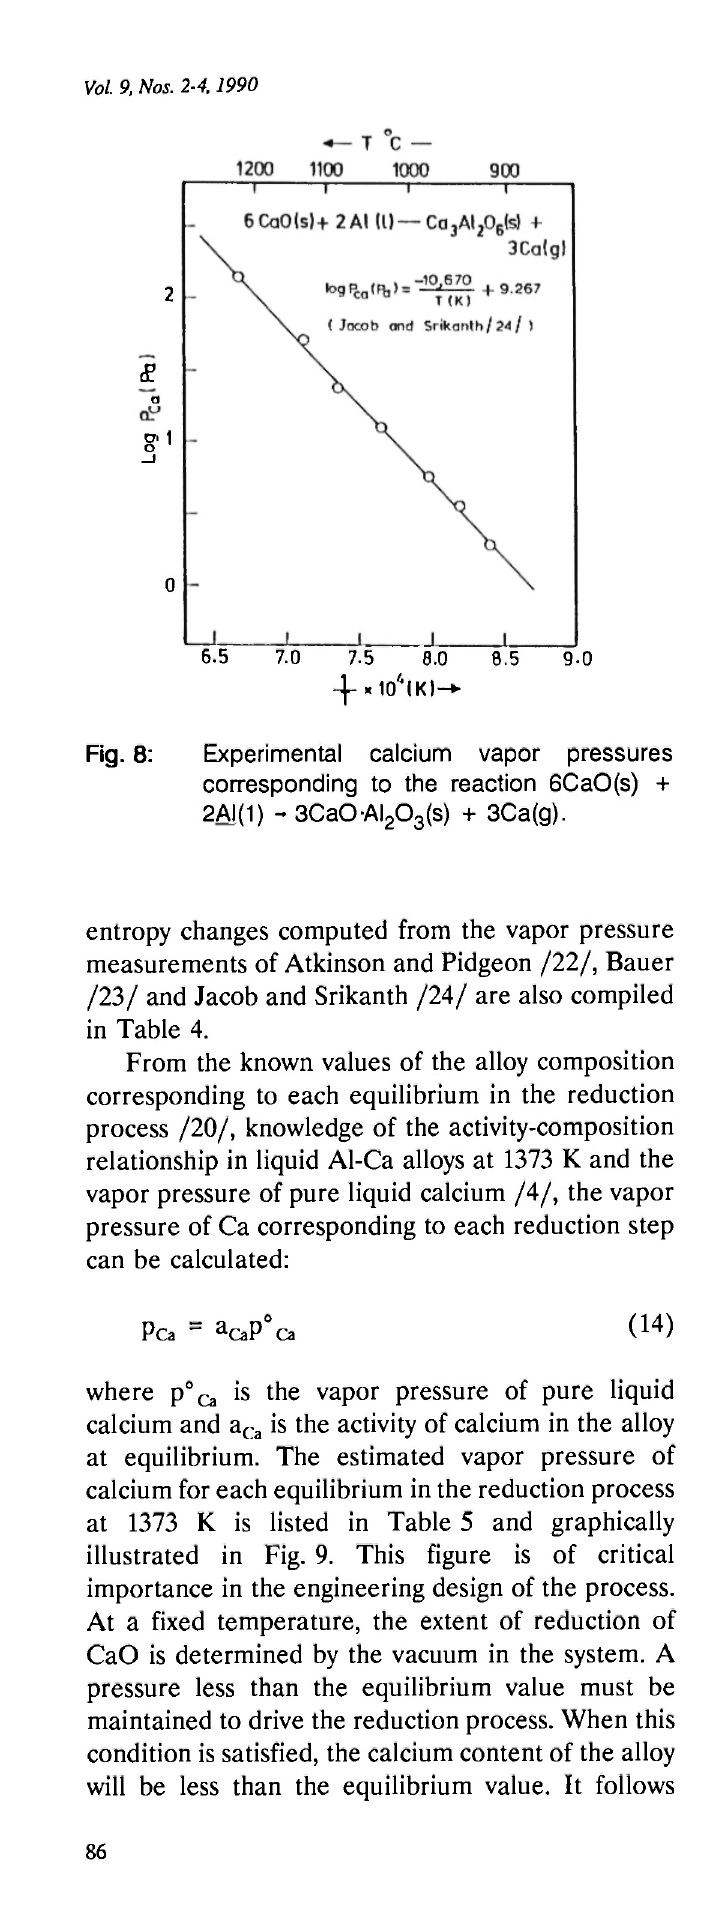
figure is of critical